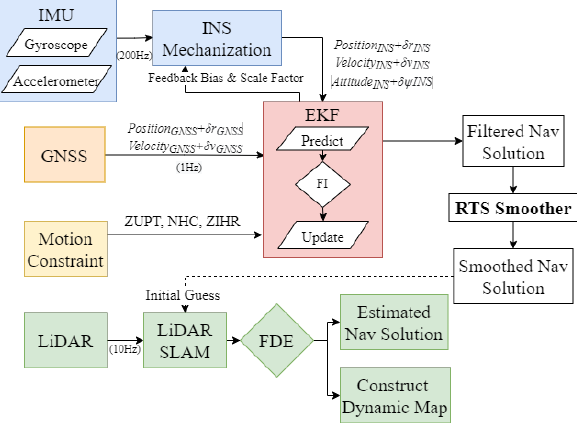
Figure 1 . Overview of LiDAR-SLAM-based navigation system